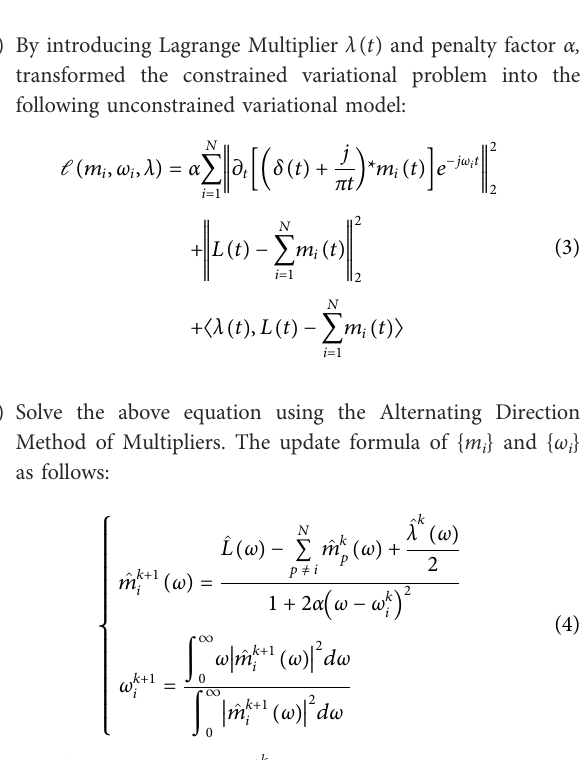
(3) By introducing Lagrange Multiplier λ ( t ) and penalty factor α ,